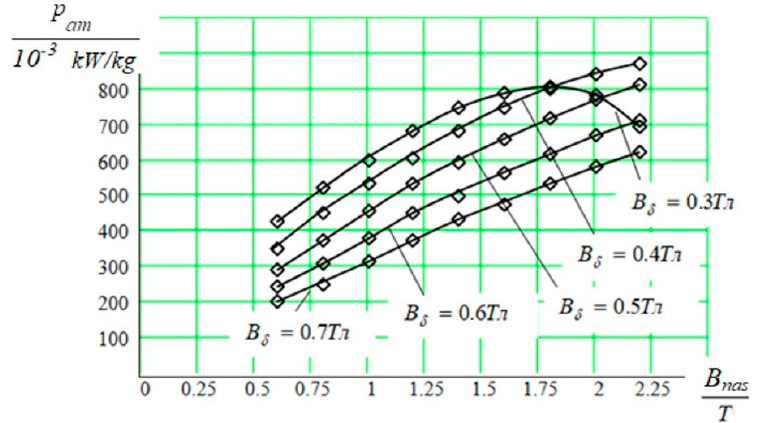
Figure 9. Dependences of the specific power p am on the induction of the saturation of the tooth and induction in the air gap.